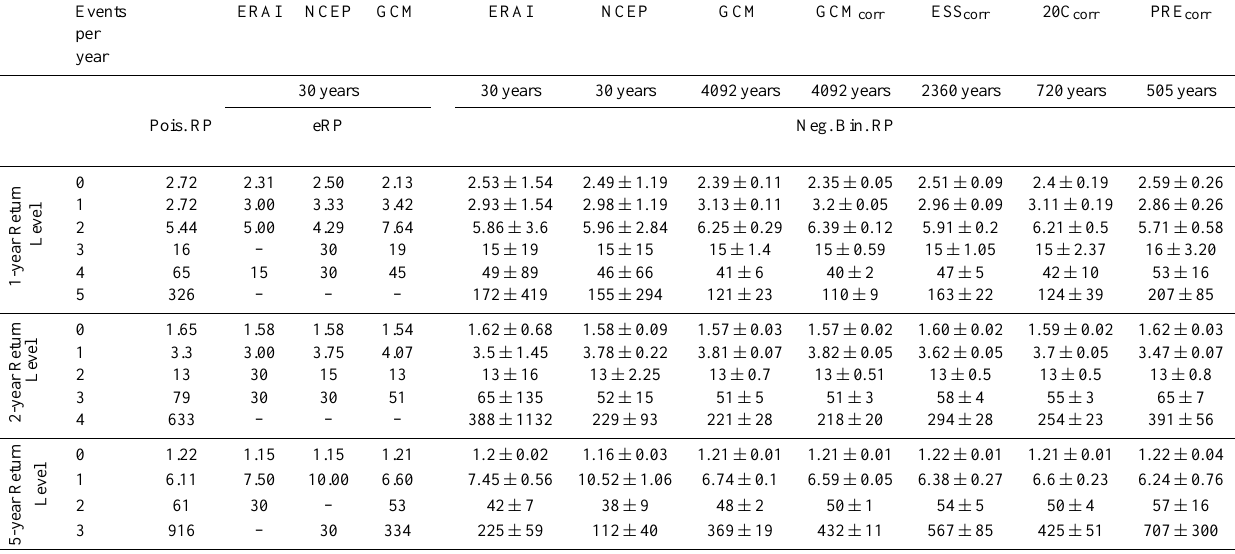
Table 2. Estimated return periods for three different return levels (1-, 2-, 5-year) based on the Poisson distribution (Pois. RP), the empirical data for each data set (eRP), and the negative binomial distribution (Neg. Bin. RP; with uncertainty estimates ∗ using the Gaussian error propagation) for NCEP, ERAI and independent selected GCM samples (GCM: all runs, GCM corr , 37 ESSENCE runs: ESS corr , 3 20C runs from MPI: 20C corr , PRE corr from MPI, 3 CSMT runs from MPI: CSMT corr ; all runs indexed with corr are bias corrected based on CWTs) considering only the number of years available for each data set respectively. The number of years is indicated below each data set. For further details see Table B1 in the Supplement.